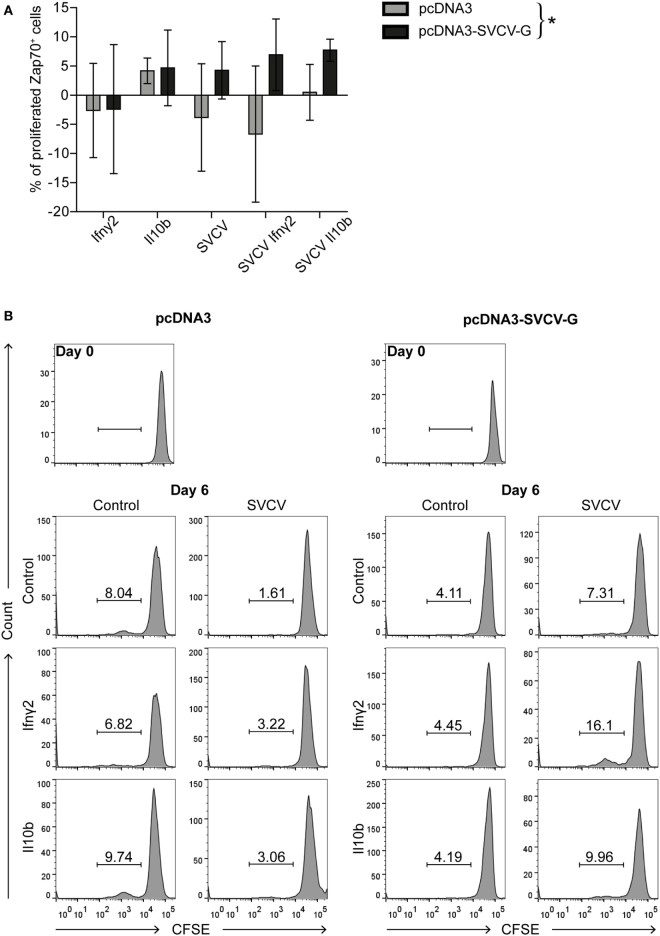
DNA vaccination against spring viremia of carp virus (SVCV) induces the formation of virus-specific T cells. PBLs were isolated 3 months after vaccination from non-vaccinated (pcDNA3) and vaccinated (pcDNA3-SVCV-G) carp. Carboxyfluorescein succinimidyl ester (CFSE)-labeled PBLs were stimulated for 6 days at 27°C with recombinant Ifnγ2 (100 ng/mL) or Il10b (0.25 U/mL) alone, or in combination with SVCV (MOI of 25). As a control, conditioned medium was used. T-cells were identified using a cross-reactive anti-Zap70 antibody, and proliferation was analyzed by flow cytometry. (A) Percentages of proliferating Zap70+ T cells are expressed relative to the respective conditioned medium control after subtraction of the percentage of proliferating cells in the medium control. For each group, bars represent average and SD of n = 7 fish/stimulus, except for the Il10b stimulated samples for which n = 3 fish were used. Asterisk (*) indicates a significant differences between the pcDNA3 and pcDNA3-SVCV-G group as assessed by one-way ANOVA. (B) Representative histogram plots of CFSE-labeled Zap70+ T cells from non-vaccinated (pcDNA3, left panel) and vaccinated (pcDNA3-SVCV-G, right panel) carp of the experiment in panel (A).